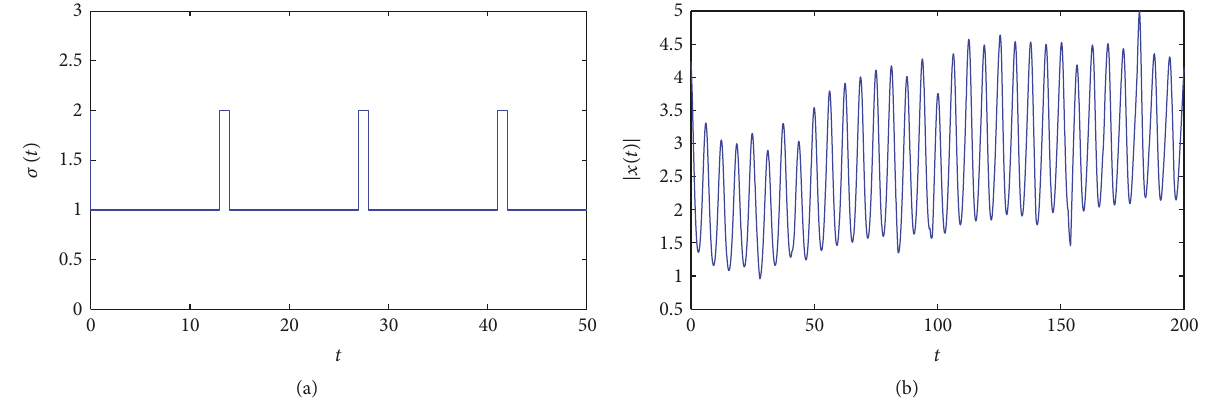
Figure 2: Simulation results for Example